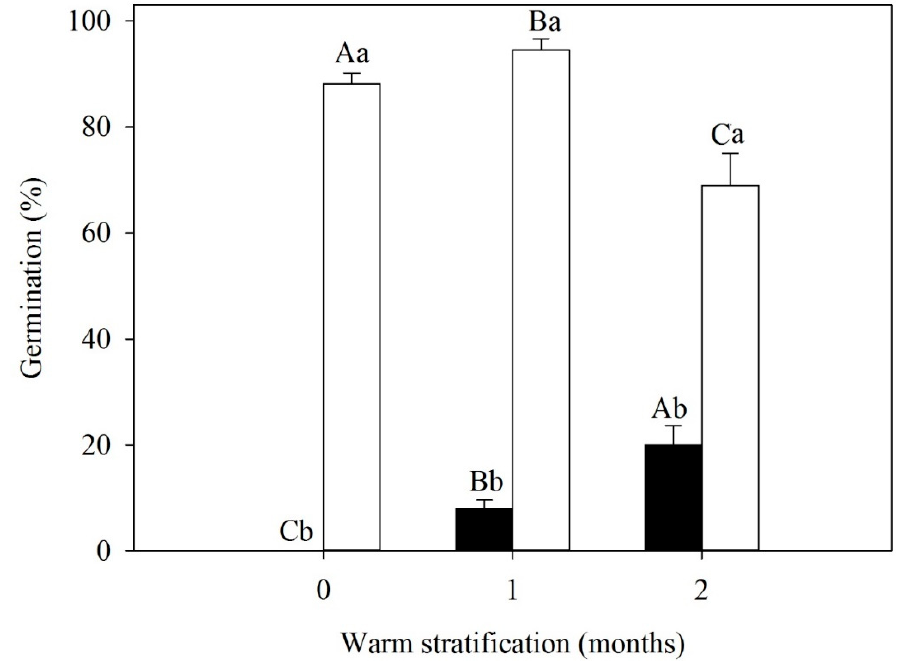
Figure 4. Effects of warm stratification (black bar) and warm + 5 months of cold stratification (white bar) on germination of Sorbus alnifolia (Siebold & Zucc.) K.Koch seeds. Error bars are mean ± se. Different uppercase letters indicate significant differences among different warm stratification time at the same stratification treatment, and different lowercase letters indicate significant differences between warm stratification and warm + 5 month of cold stratification at the same warm stratification time ( p < 0.05).